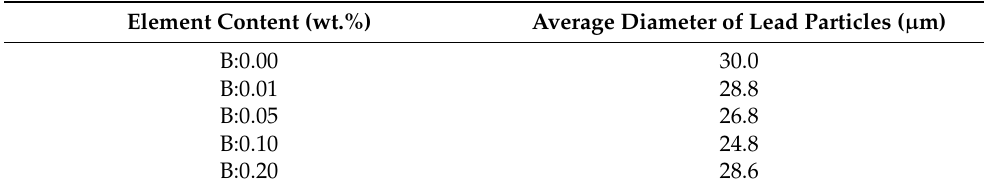
Table 1. Data table of average diameter of lead particles after adding different elements to lead–tin bronze.